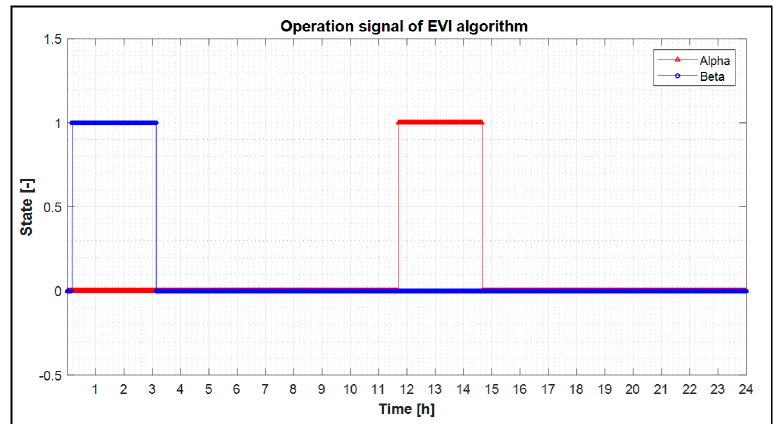
Figure 19. Operation signal of EVI algorithm.